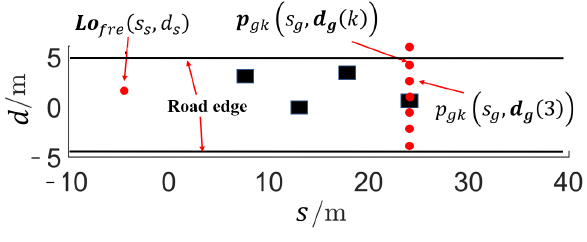
(cid:0) s g , d g ( k ) gk